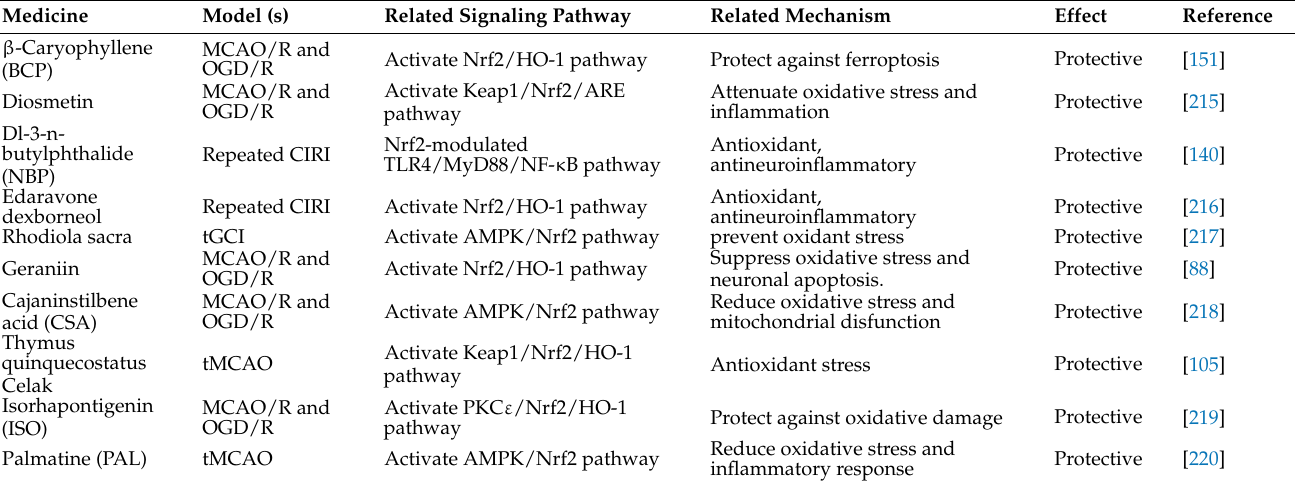
Table 2. Several traditional Chinese medicine/compounds affect cerebral ischemic stroke by regulat- ing Nrf2 signaling